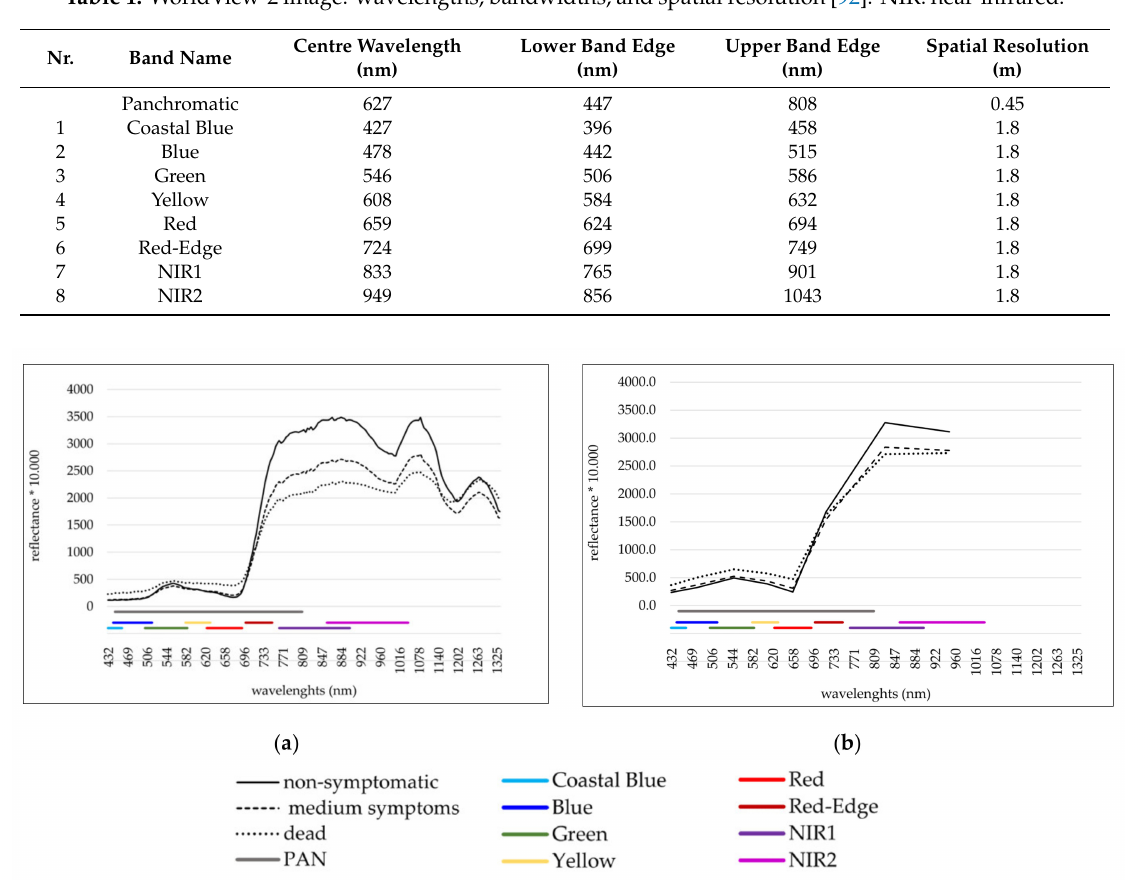
Figure 3. Position of WorldView-2 (WV2) bands and kauri spectra for non-symptomatic, medium, and dead crowns based on ( a ) an airborne hyperspectral image (448 spectral bands) and ( b ) the pan-sharpened WV2 multispectral bands